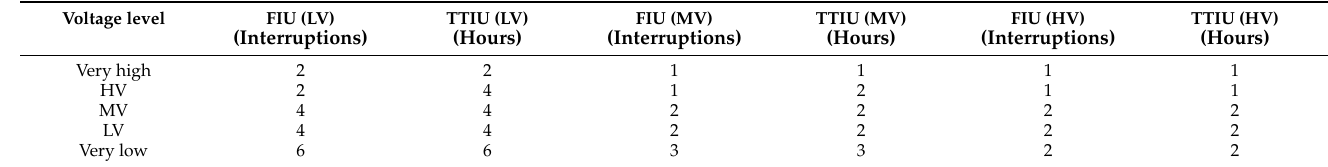
Table 13. Tolerance limits for indicators in Venezuela by voltage level.